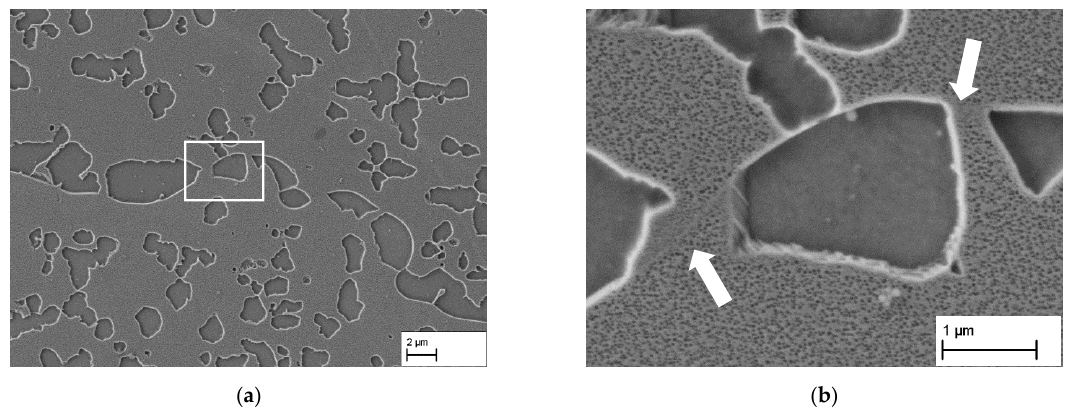
Figure 4. ( a ) Serrated grain boundary after slow cooling (0.25 K/min) from 1473 K. ( b ) Enlarged detail from ( a ), where the grain boundary within the matrix is clearly visible due to fine secondary γ (cid:48) -particles formed during air-cooling after reaching 1373